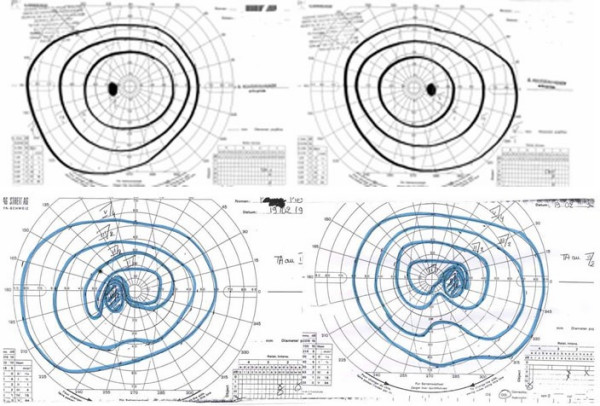
Goldman perimeter showing normal visual fields (upper panel) and bitemporlal quadranopsia due to optic chiasm compression by a pituitary adenoma (lower panel).